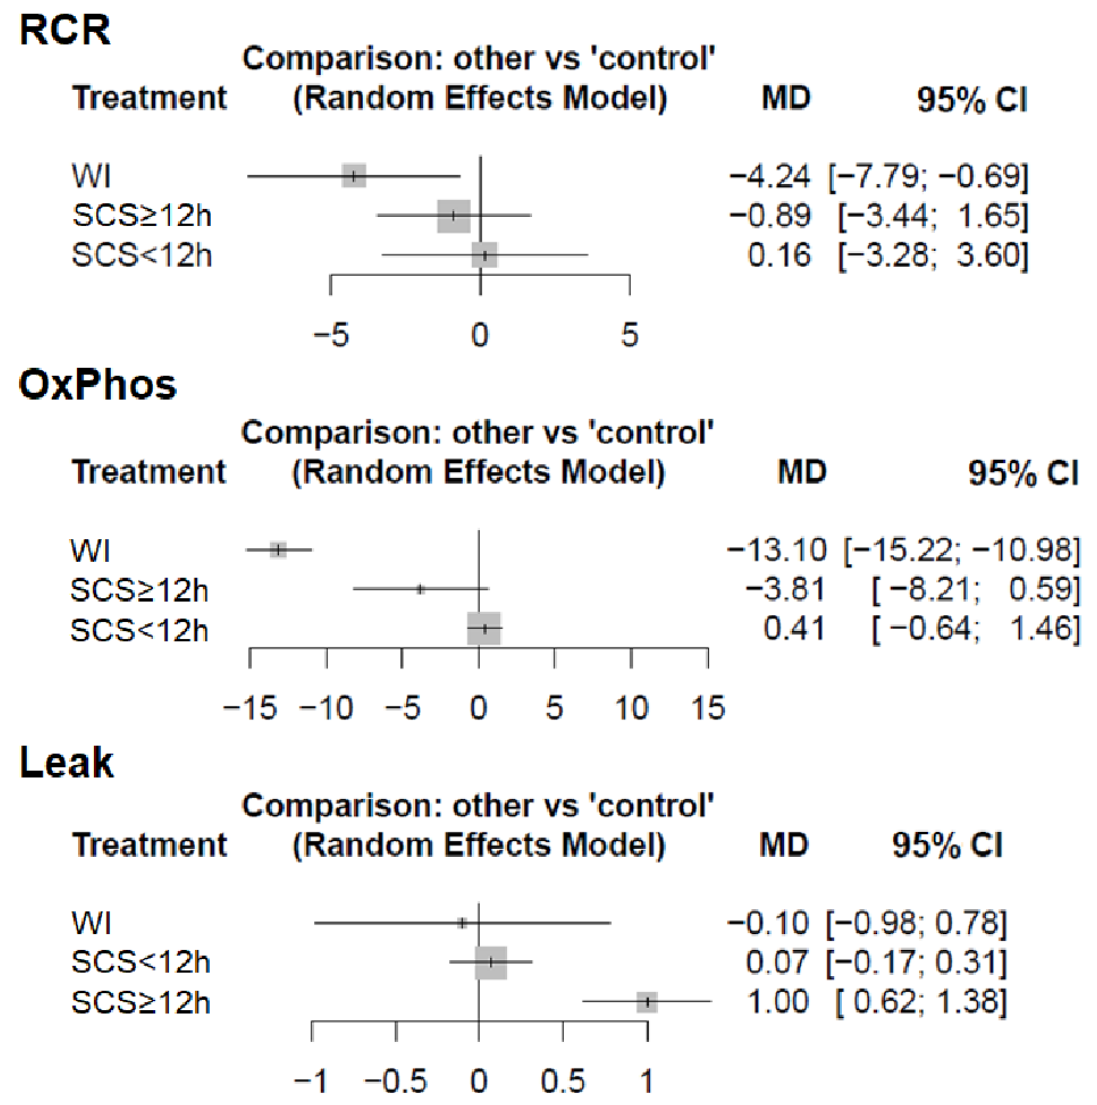
Figure 6. Comparison of complex I-related mitochondrial respiratory function following static cold storage. SCS ≥ 12 h: static cold storage for over 12 h; SCS < 12 h: static cold storage for less than 12 h; WI: warm ischemia; OxPhos: oxidative phosphorylation; Leak: leak respiration; CI: confidence interval.